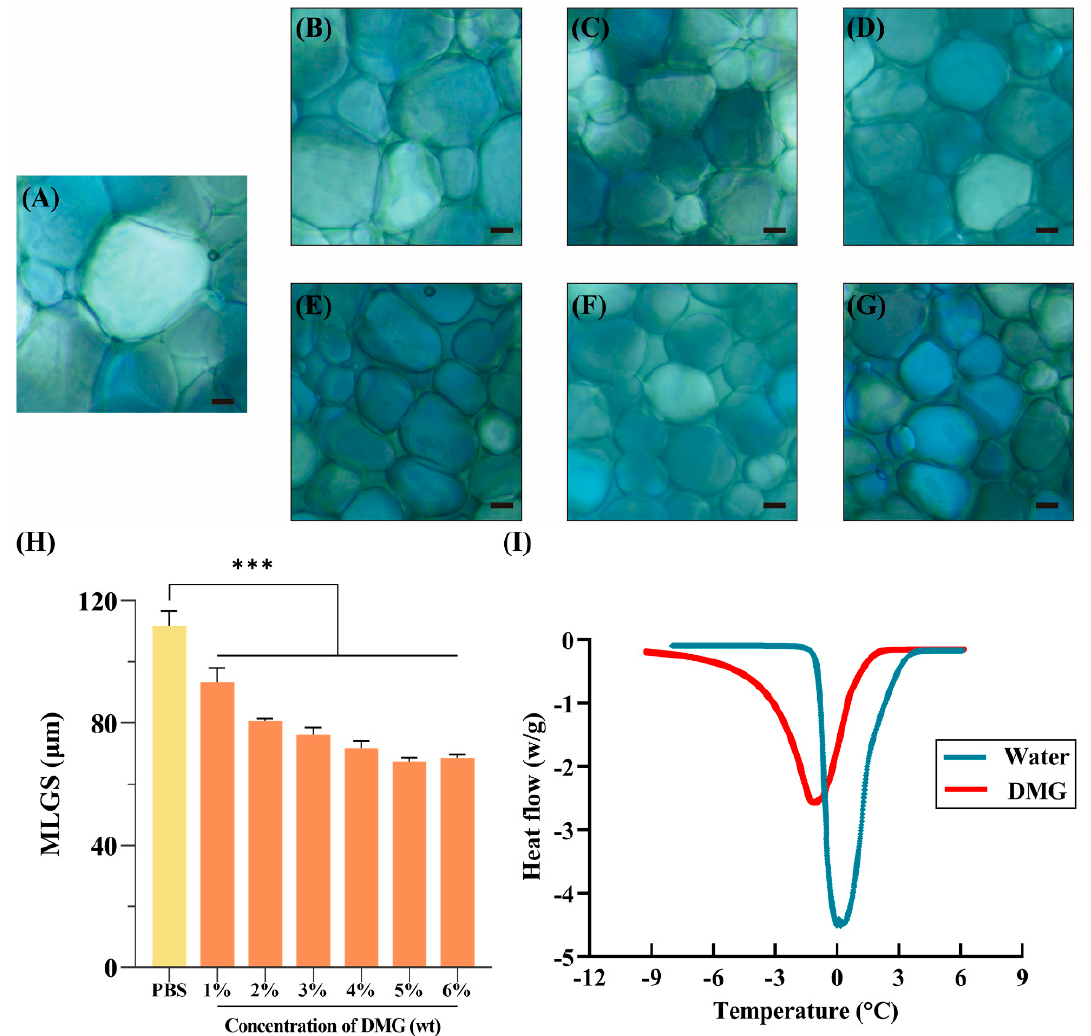
Figure 4. Ability to reduce mechanical damage. The representative images of ice crystals in ( A ) PBS, ( B ) 1% DMG, ( C ) 2% DMG, ( D ) 3% DMG, ( E ) 4% DMG, ( F ) 5% DMG, and ( G ) 6% DMG. ( H ) Quanti- tative analysis of IRI activity through mean largest grain sizes (MLGS). ( I ) The heat flow of water and 4% DMG during the melting process. Scale bar = 10 µ m. *** p <